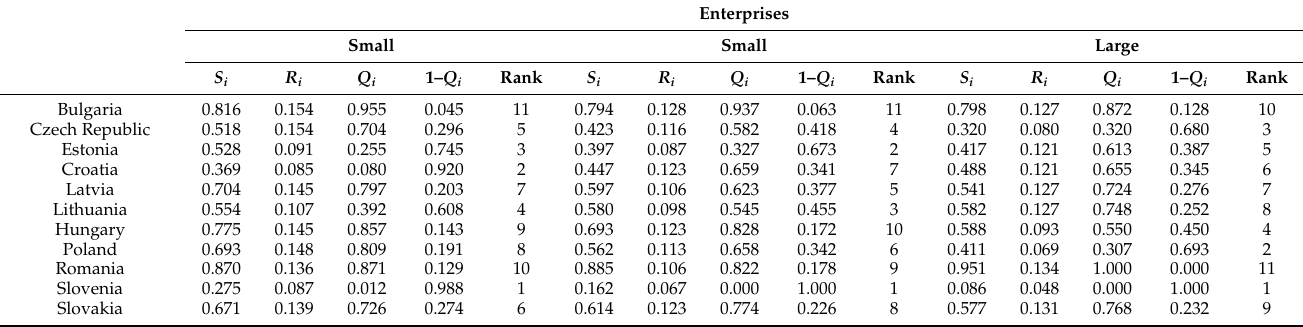
Table 9. Ranking of the CEE countries in terms of the level of digitalization of individual groups of enterprises determined by the VIKOR method. Enterprises Small Small